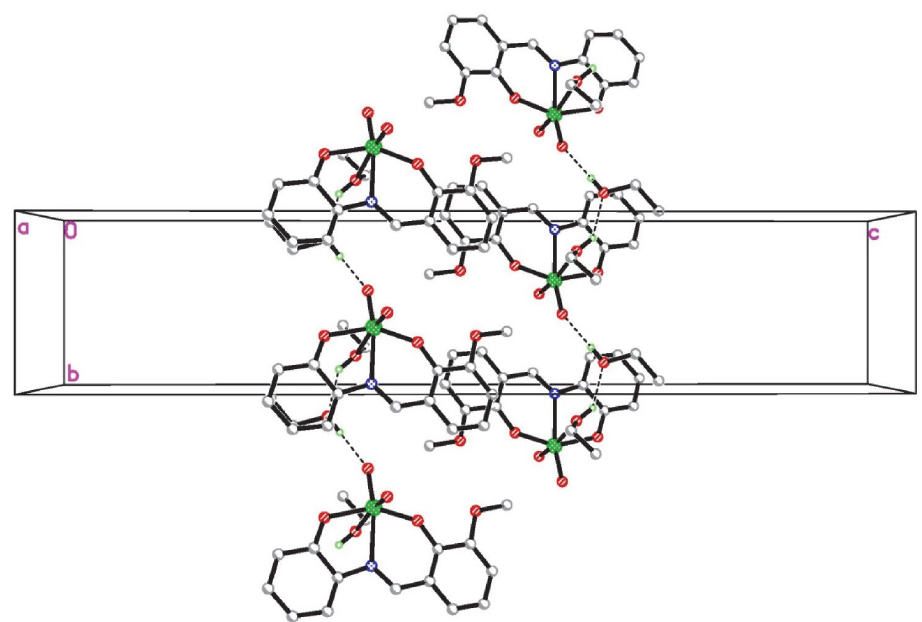
Figure 2. The hydrogen bonds (dashed lines) linked molecules into one dimensional chains of complex 1 , viewed along the a axis.